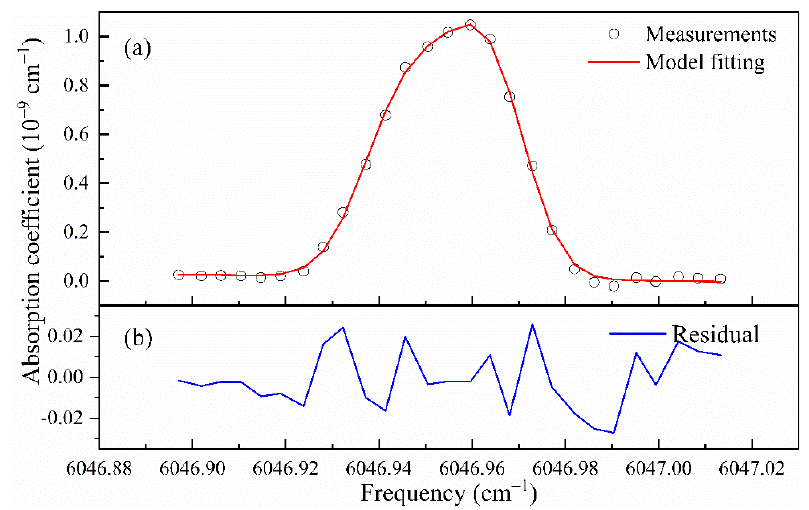
Figure 9. ( a ) Trace CH 4 measurements near 6046.95 cm −1 and ( b ) fitting residuals.